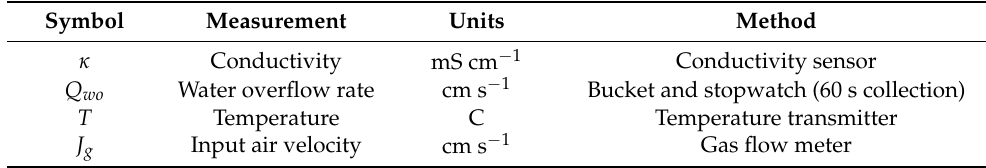
Figure 3. Schematic of experimental apparatus. Table 1. Summary of experimental measurements.